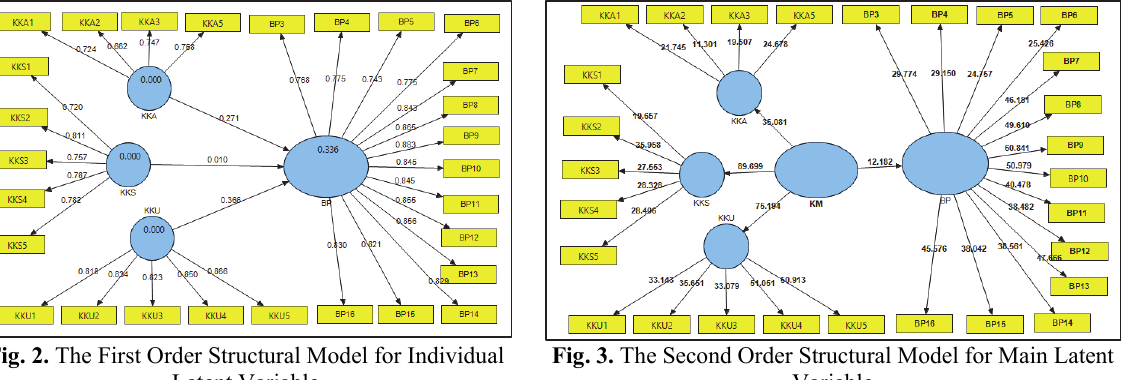
Fig. 2. The First Order Structural Model for Individual Fig. 3. The Second Order Structural Model for Main Latent Variable